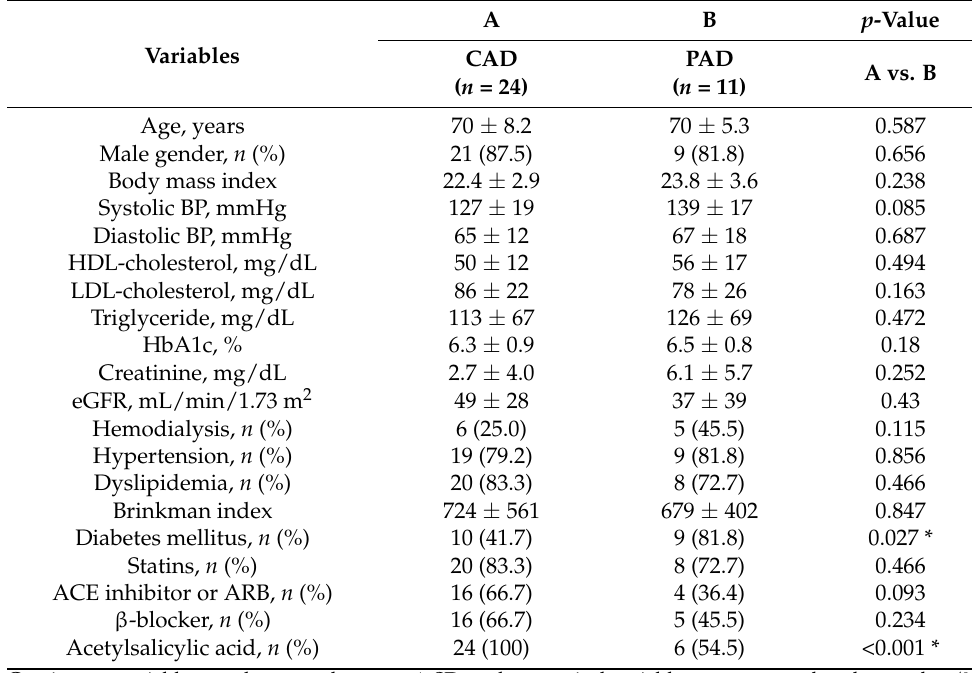
Table 2. Clinical baseline characteristics of patients with CAD or